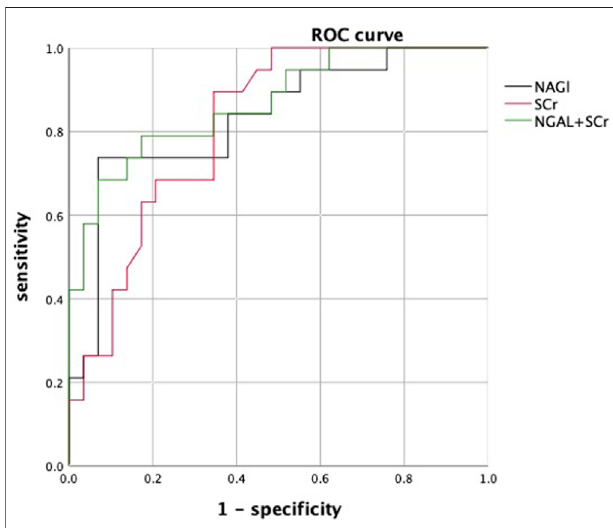
FIGURE 2 | ROC curves of urinary NGAL, SCr, and NGAL + SCr. Abbreviations: ROC: receiver operating characteristic curve; SCr: serum creatinine; NGAL: neutrophil gelatinase-associated lipocalin.